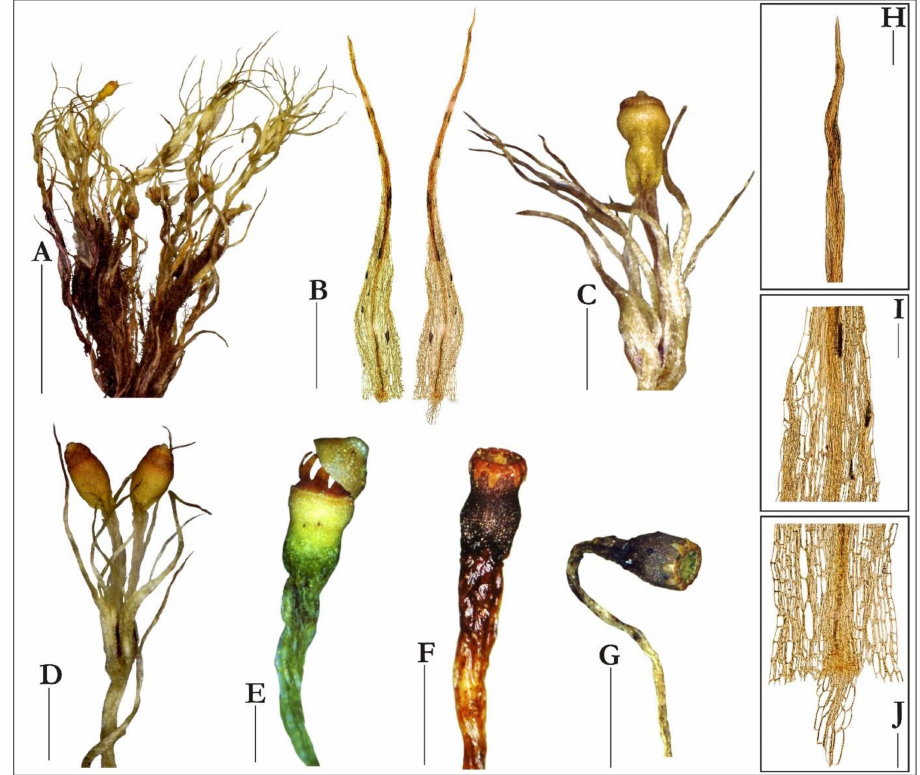
Figure 3. Macro and micro photographs of Splachnum pensylvanicum taken from the specimens from Kamanos mire in Lithuania: ( A ) portion of dry tuft showing the plants with numerous mature sporophytes and gametangia, ( B ) upper leaves, ( C ) portion of shoot with mature operculate capsule, ( D ) shoot with two operculate capsules, ( E – G ) deoperculate capsules, ( H ) apex of leaf subula, ( I ) upper cells at leaf shoulder, ( J ) basal cells. All taken from KRAM B-242425 ( A – D ; H – J ) and KRAM B-242426 ( E – G ). Scale bars: ( A )—2 cm, ( B )—0.5 mm, ( C )—1.5 mm, ( D )—1 mm, ( E – F )—0.5 mm, ( G )—1.5 mm, ( H – J )—100 µ